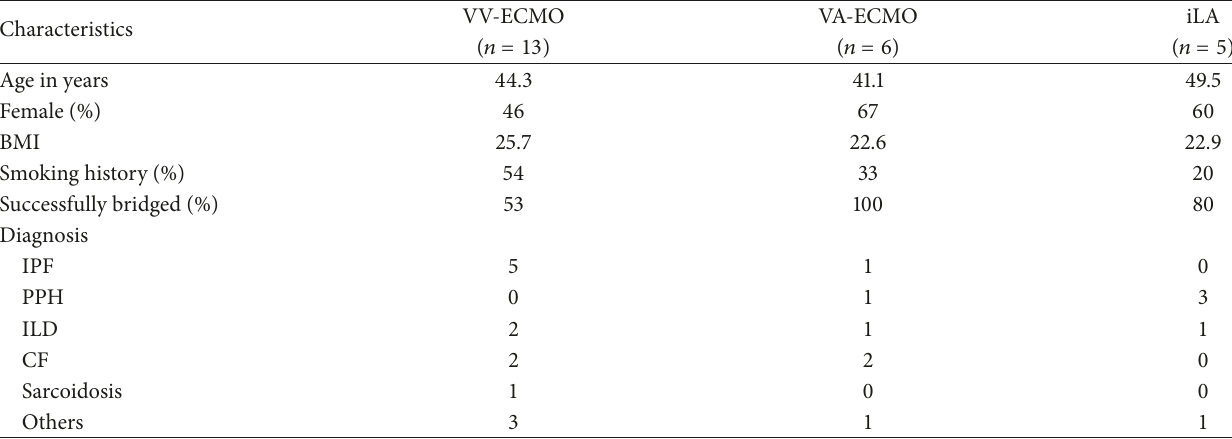
Table 1: Patient